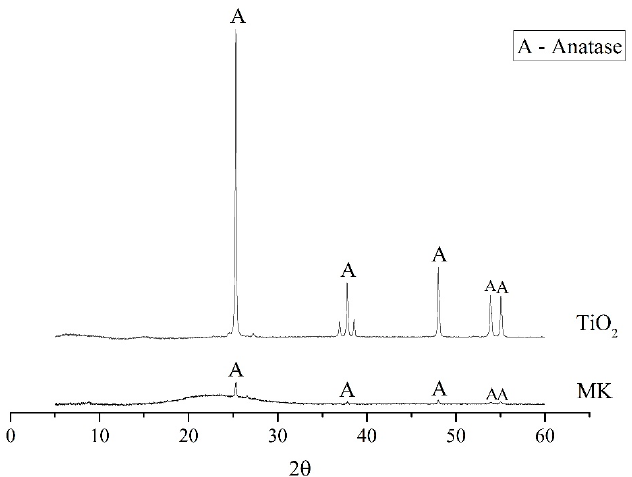
Figure 2. XRD patterns of the raw materials.